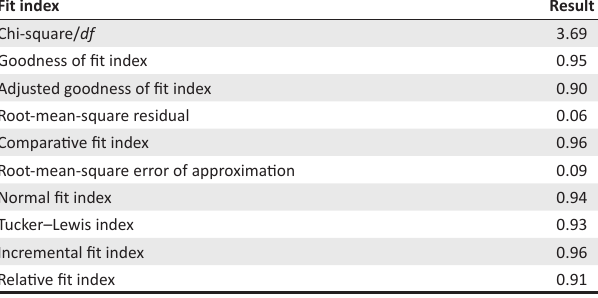
TABLE 4: Confirmatory factor analysis – model fit index results.